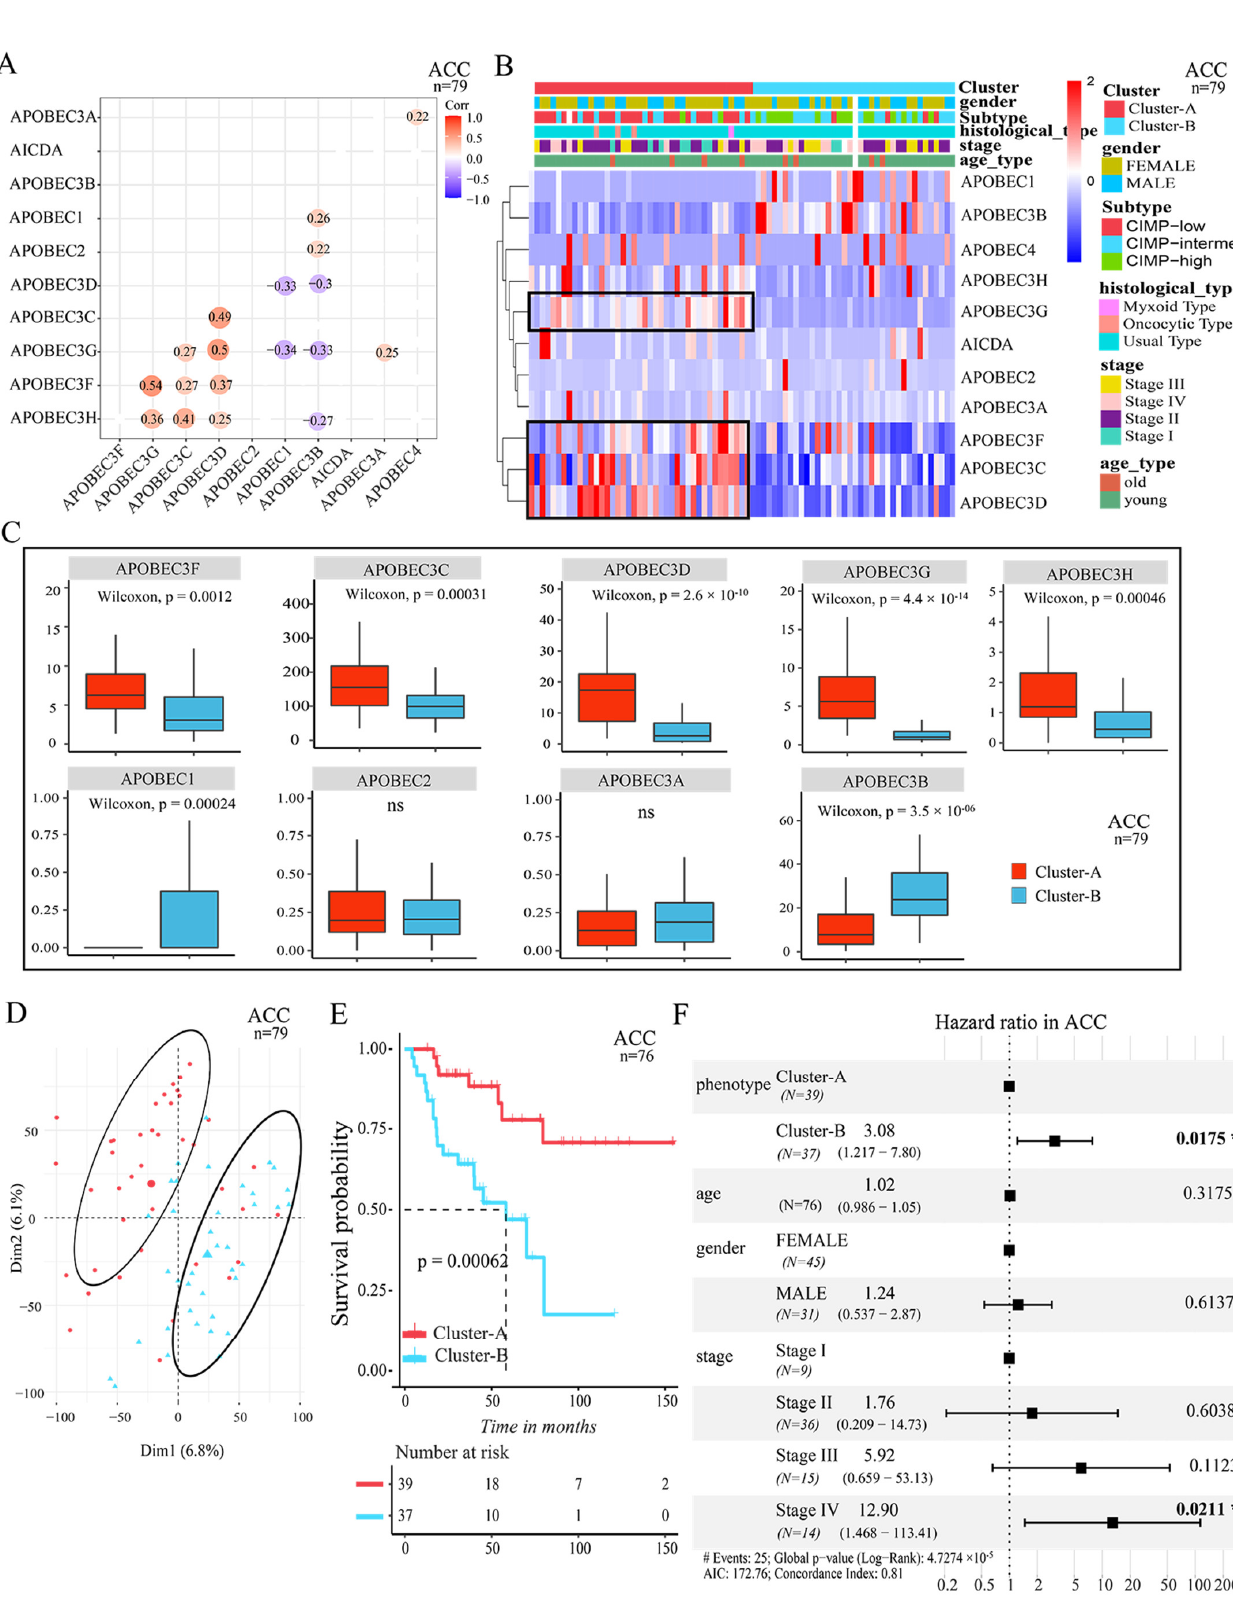
Figure 3. Patterns of APOBEC-mediated stratification and prognosis characteristics of each pattern in ACC. ( A ) Correlations between the expression of 11 APOBEC genes in ACC. A positive correlation is indicated in orange, and a negative correlation is indicated in purple. The color intensity and size of the circle are proportional to the correlation coefficient; ( B ) Unsupervised clustering of 11